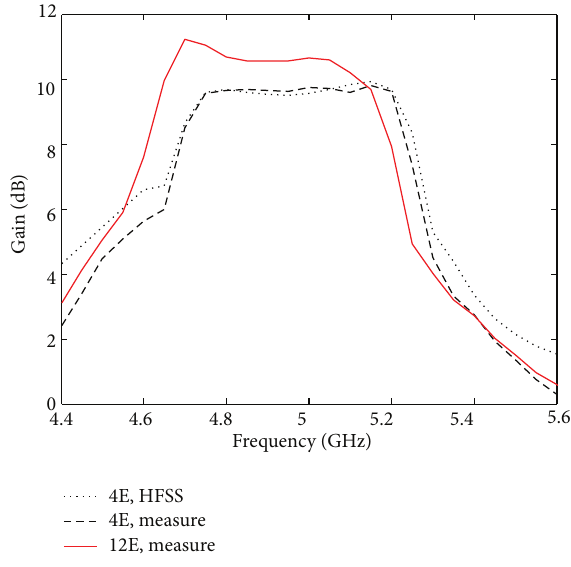
Figure 6: Gains for the 4-element Yagi array (Figure 2) and the 12- element Yagi array (Figure 7).